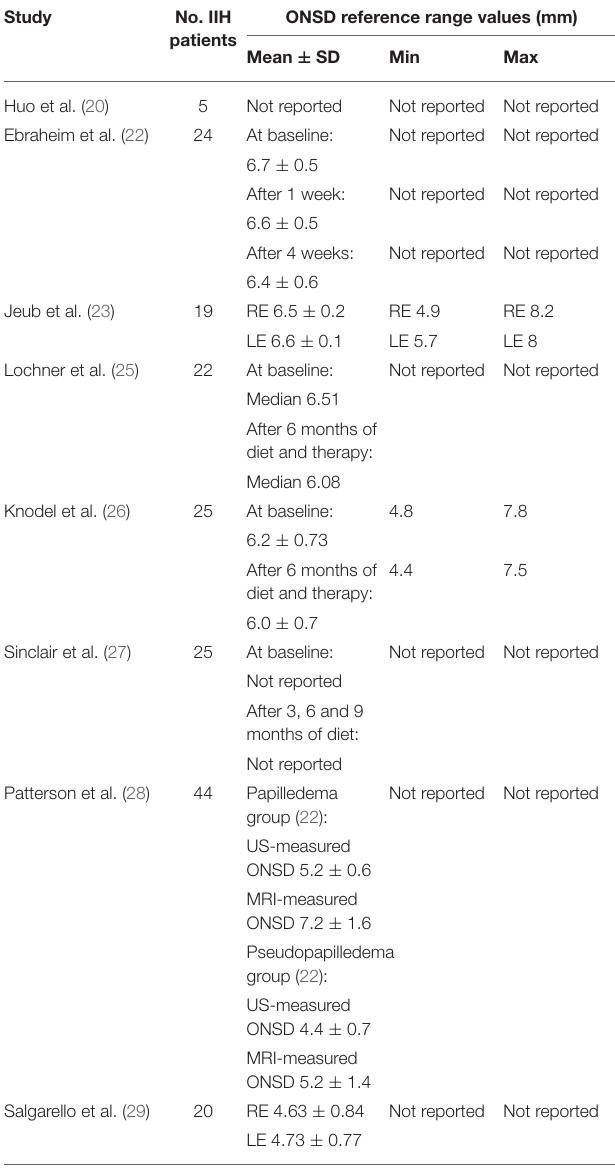
TABLE 2 | Summary of the ONSD ultrasound reference range values established in other studies on people with IIH. Study No. IIH